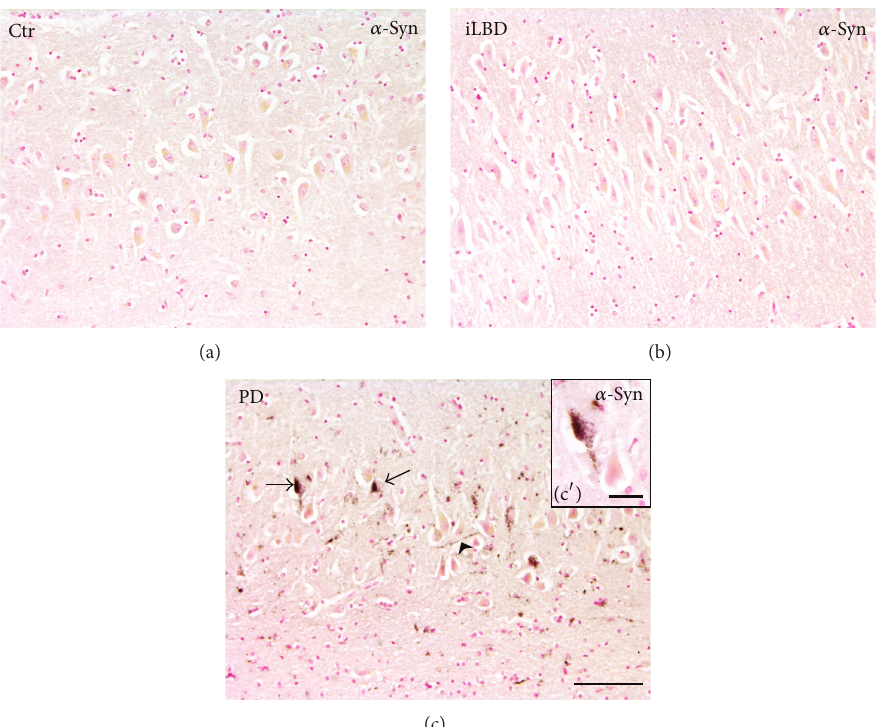
Figure 1: 𝛼 -Synuclein pathology present in the hippocampus of PD cases. (a-b) 𝛼 -Synuclein immunoreactivity (IR) in CA of control and iLBD subjects is absent compared to (c) 𝛼 -synuclein IR (LBs: arrow, LNs: arrowhead) in the CA region of PD patients; bar (a–c) = 100 𝜇 m; higher magnification (c 󸀠 ) bar = 20 𝜇